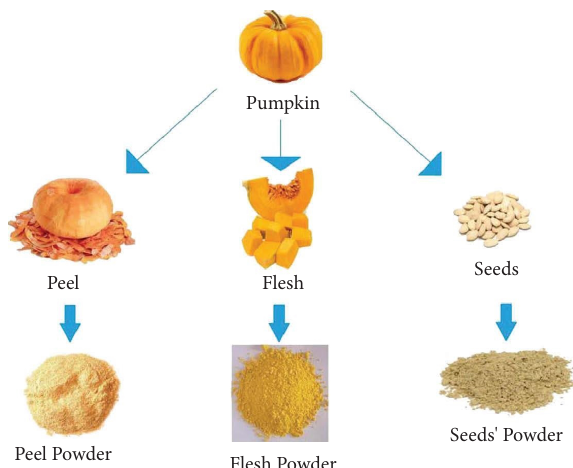
Figure 1: Graphical overview of pumpkin peel, fesh, and seed powders